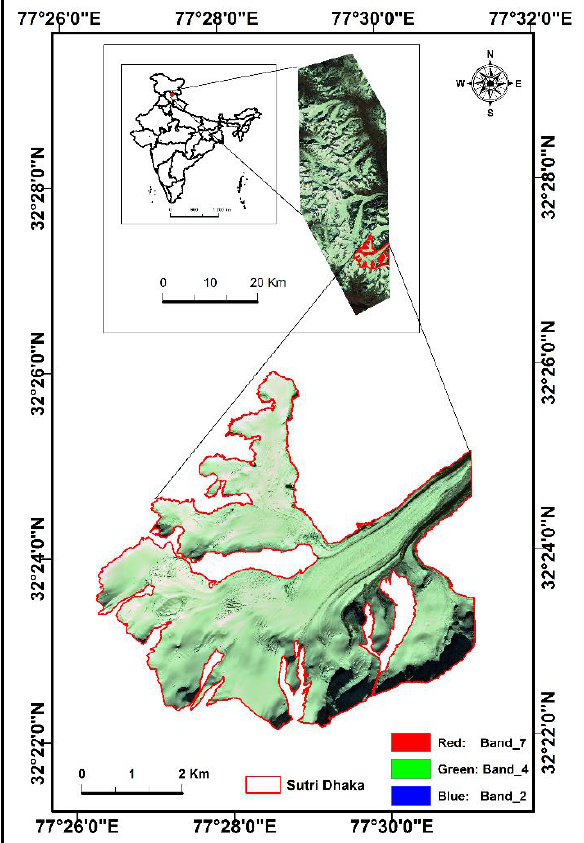
Table 2. WorldView-2 sensor specifications